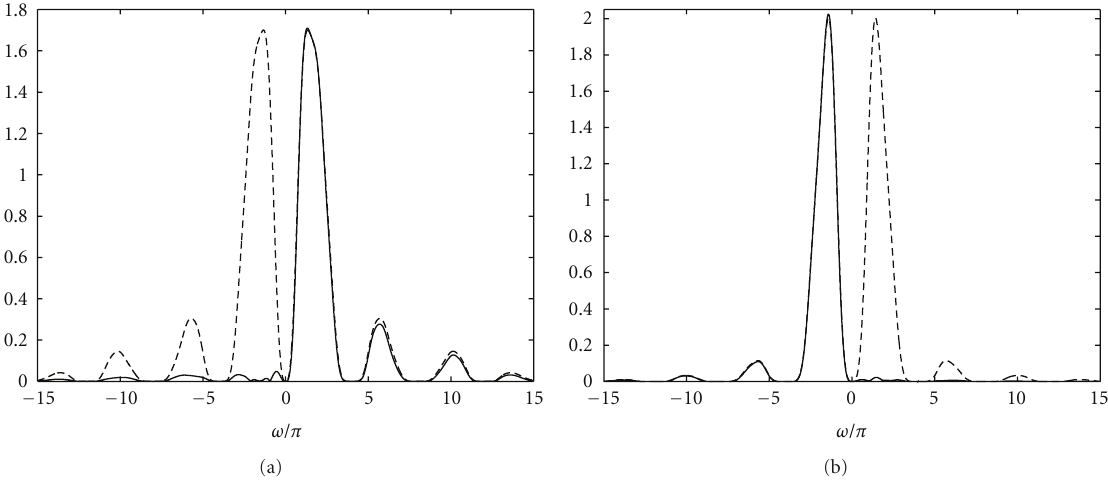
Figure 4: Magnitude responses of wavelet bases in Example 2. (a) Magnitude responses of decomposition wavelets: | Ψ h ( ω ) + i Ψ g ( ω ) | (the solid line) and 2 | Ψ h ( ω ) | (the dashed line). (b) Magnitude responses of reconstruction wavelets: | (cid:2) Ψ h ( ω )+ i (cid:2) Ψ g ( ω ) | (the solid line) and 2 | (cid:2) Ψ h ( ω ) | (the dashed line).